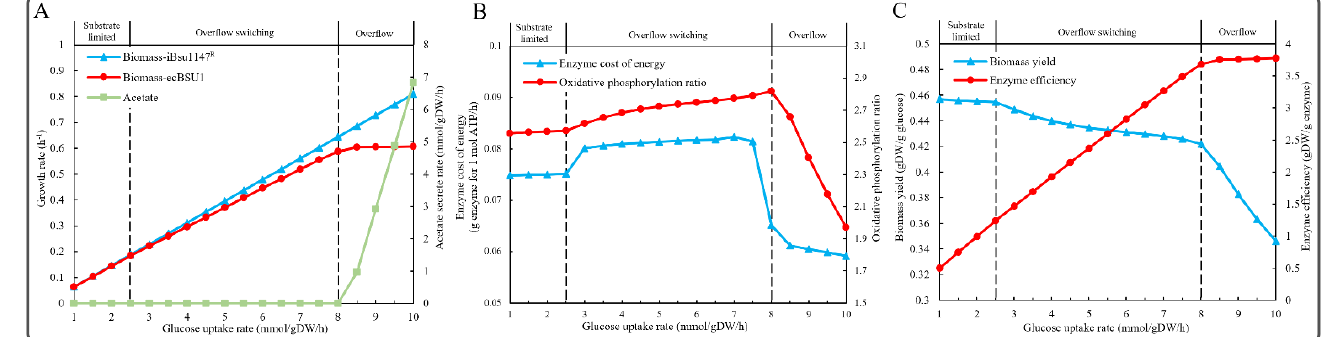
Figure 4. Simulation of overflow metabolism. ( A ) Comparison of in silico overflow between iBsu1147 R and ecBSU1. ( B ) Enzyme cost of energy metabolism and oxidative phosphorylation ratio. ( C ) Trade-off phenomenon simulated by ecBSU1.